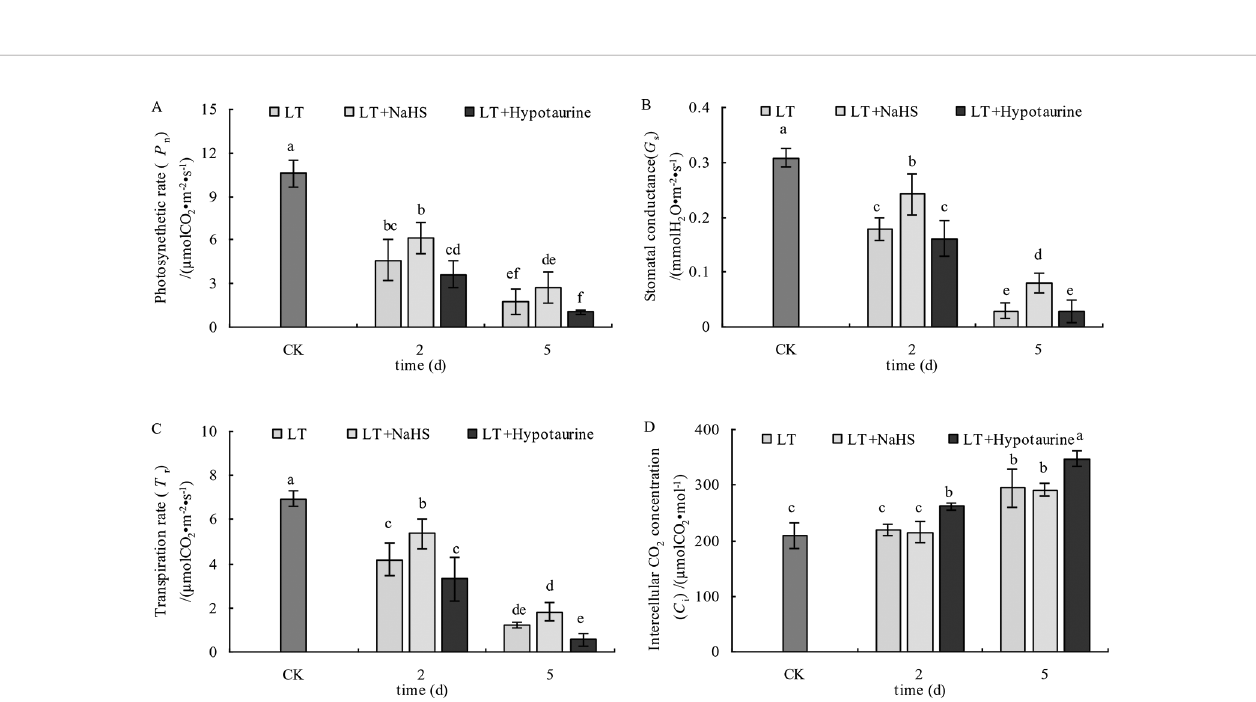
FIGURE 8 | Effects of exogenous NaHS and Hypotaurine on net photosynthetic rate (A) , stomatal conductance (B) , transpiration rate (C) , and intercellular CO 2 concentration (D) of blueberry leaves under low temperature stress. The data in the fi gure are from fi ve replicated experiments (n=5), and represent means ± standard error (SE). Different small letters show signi fi cant differences ( P < 0.05).CK: room temperature control at 25°C; LT: low temperature treatment; LT + NaHS: low temperature treatment at 4 – 6°C after spraying 0.5 mmol·L – 1 NaHS; LT + Hypotaurine: low temperature treatment at 4 – 6°C after spraying leaves with